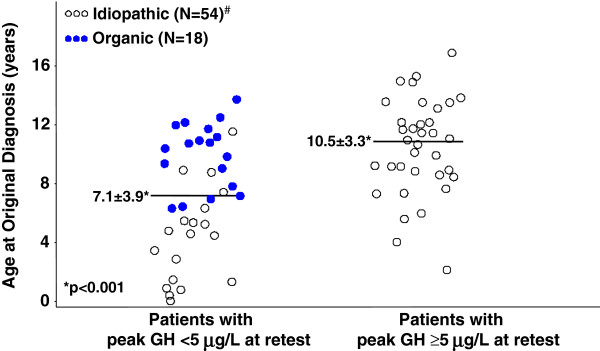
Age at original childhood diagnosis of GH deficiency. Distribution of age at original diagnosis for patients who retested as GH deficient (left) vs. those who retested as GH sufficient (right). Within the persistently GH-deficient group, patients with history of idiopathic GH deficiency were significantly younger at diagnosis than those with history of organic GH deficiency (Table 1). Horizontal lines represent mean ages at initial diagnosis for patients with history of IGHD. GH = growth hormone; N = total number of patients in each category (organic vs. idiopathic).